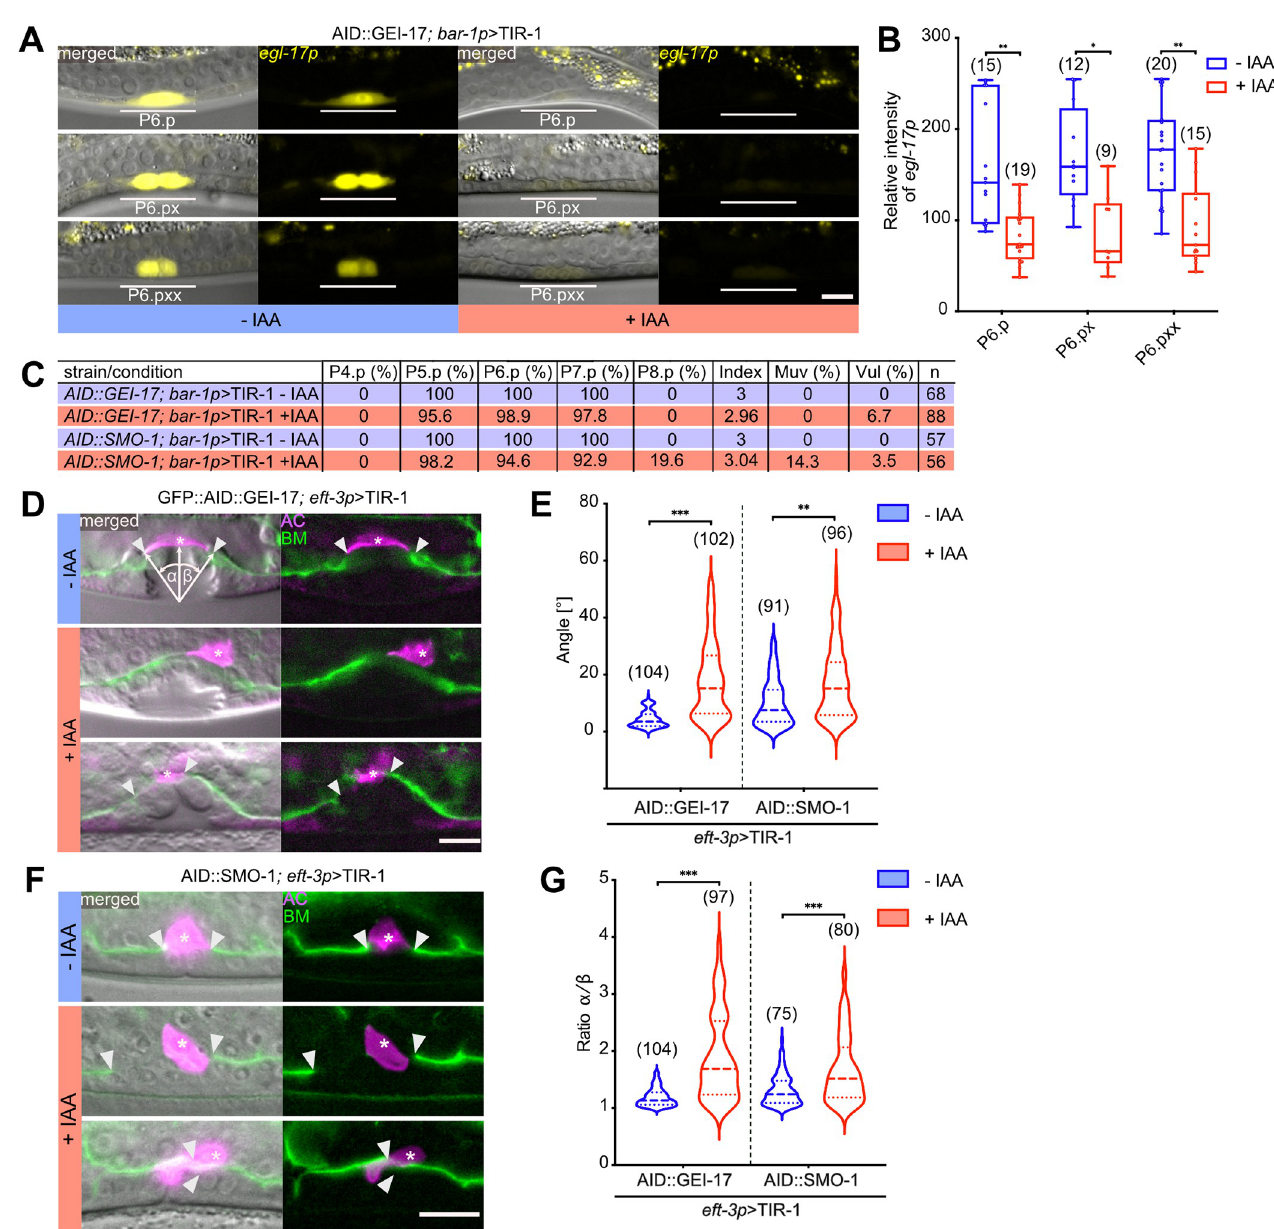
Fig 3. The SUMO pathway regulates different stages of vulval development. (A) egl-17p > yfp expression in P6.p and its descendants P6.px and P6.pxx after VPC-specific degradation of GEI-17. (B) Quantification of egl-17p > yfp expression levels after AID::GEI-17 depletion. Box plots show the median values with the 25 th and 75 th percentiles and whiskers indicate the maximum and minimum values. (C) VPC induction upon degradation of AID::GEI-17 and AID::SMO- 1. For each strain and condition, the percent of induced VPCs, the average number of induced VPCs per animal (index), percent of multivulva (Muv, index > 3) and vulvaless (Vul, index < 3) animals, and the number of animals scored (n) are shown. (D) AC displacement, AC fusion defects and asymmetric BM breaching after global AID::GEI-17 and (F) AID::SMO-1 degradation. The BMs are labelled with LAM-1::GFP in green and the AC with cdh-3p > mCherry:: moeABD in magenta. White arrowheads indicate the borders of the BM breaches and asterisks the AC. The left panels show the fluorescent signals merged with the corresponding DIC images. The angles α and β used to quantify AC alignment and symmetry of the BM breaching are illustrated in the top left panel. (E) Quantification of the AC displacement and (G) BM breaching asymmetry after degradation of GEI-17 and SMO-1 using the global eft-3p > tir-1 driver. See also S3 Fig for the results obtained with tissue-specific tir-1 drivers. Dashed lines in the violin plots (E, G) show the median values and the dotted lines the 25 th and 75 th percentiles. In all experiments, untreated controls are labelled with–IAA (blue) and animals treated with 1 mM auxin +IAA (red). In each graph, the numbers of animals scored are indicated in brackets. Statistical significance was determined with a Kolmogorov-Smirnov test (B, E, G) . p-values are indicated as � p � 0.05; �� p � 0.01; ��� p � 0.001. The scale bars are 10 μ